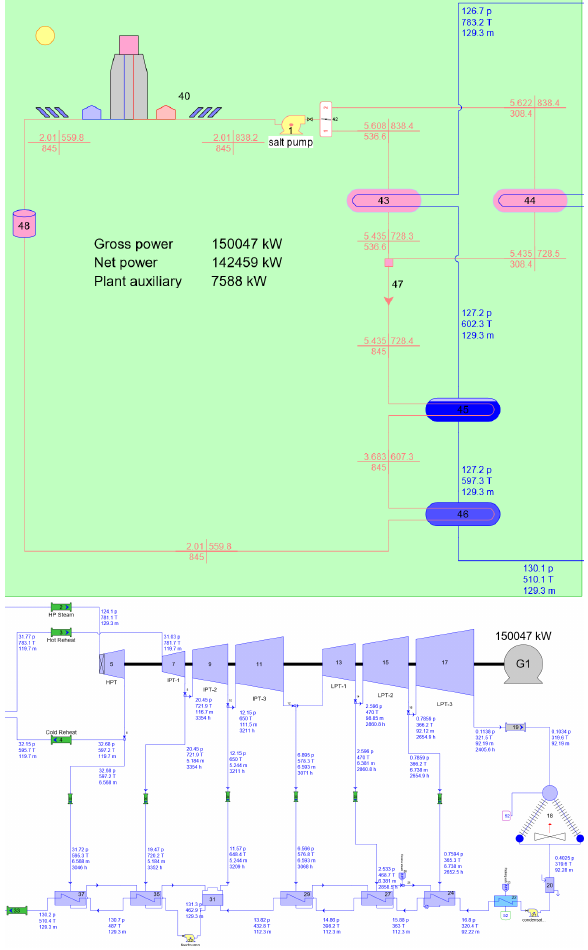
Fig. 1: Thermoflow scheme of the design point balance for the Rice concentrating ST facility. Courtesy of Thermoflow,